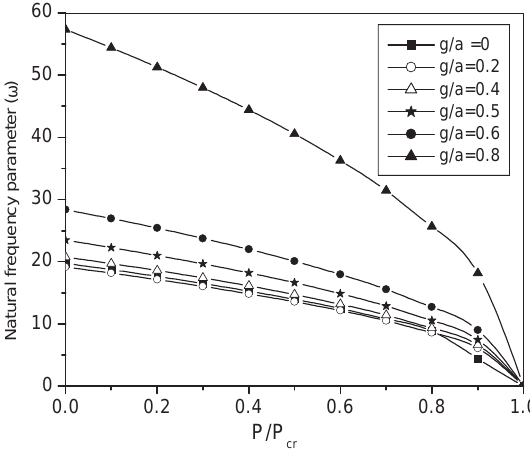
Fig. 5. As Fig. 4, but for clamped edges.